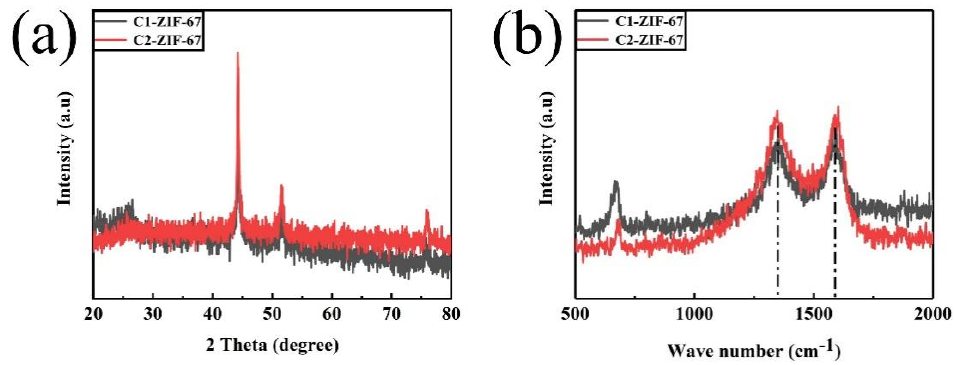
Figure 4. ( a ) XRD patterns and ( b ) Raman of the C1-ZIF-67 and C2-ZIF-67.